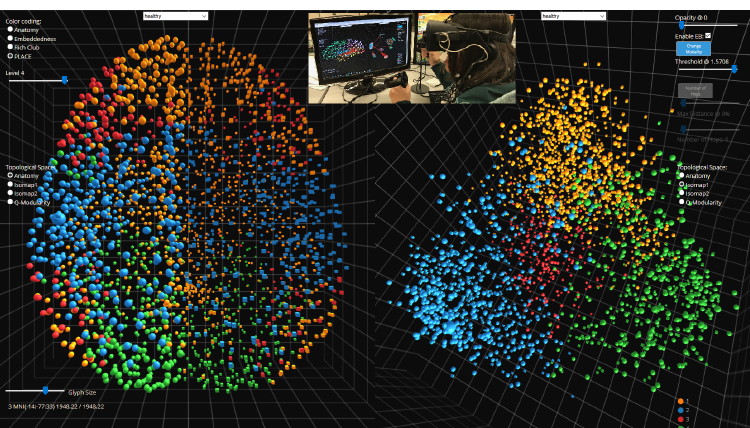
Figure 4. Investigating connectome data from different perspectives in NeuroCave. Left side shows the connectome in the anatomical space and the intrinsic space on the right with color legend right bottom. A neuroscientist is shown in the top of the image exploring the 3D data with a VR headset. Users are allowed to switch between standard and VR modes. Source: